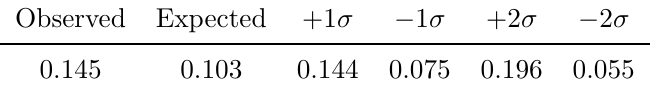
Table 9. Observed and expected limits on B inv for a Higgs boson with a mass of 125 GeV calculated at the 95% CL for a 139 fb − 1 data set. The ± 1 σ and ± 2 σ variations of the expected limit are also